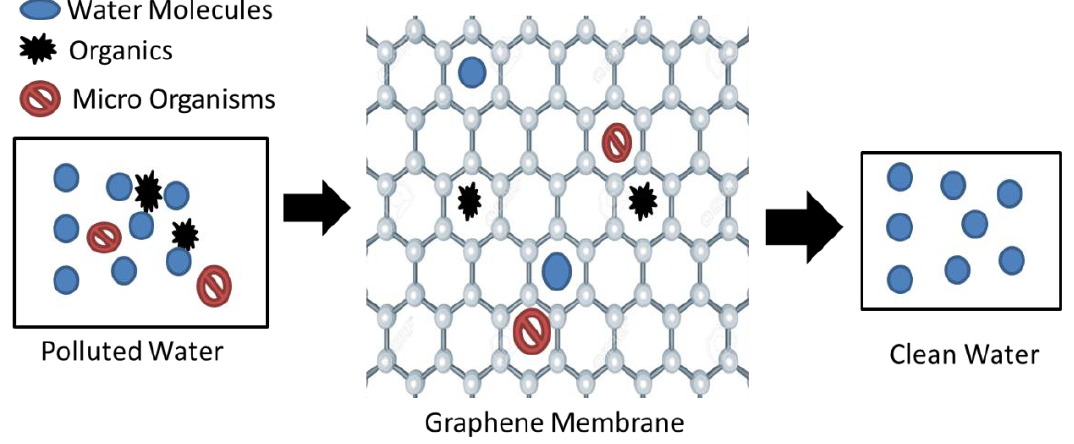
Figure 2. Graphene water purification method [28].